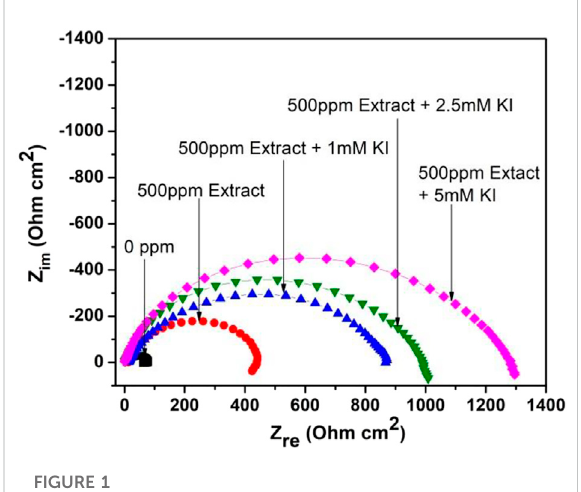
FIGURE 1 Nyquist diagram showing the effect of different concentrations of KI on the corrosion inhibition of 1018 steel in acidmediausing M.sativa aerialpartswith500 ppmconcentration at 25 ± 2 ° C.